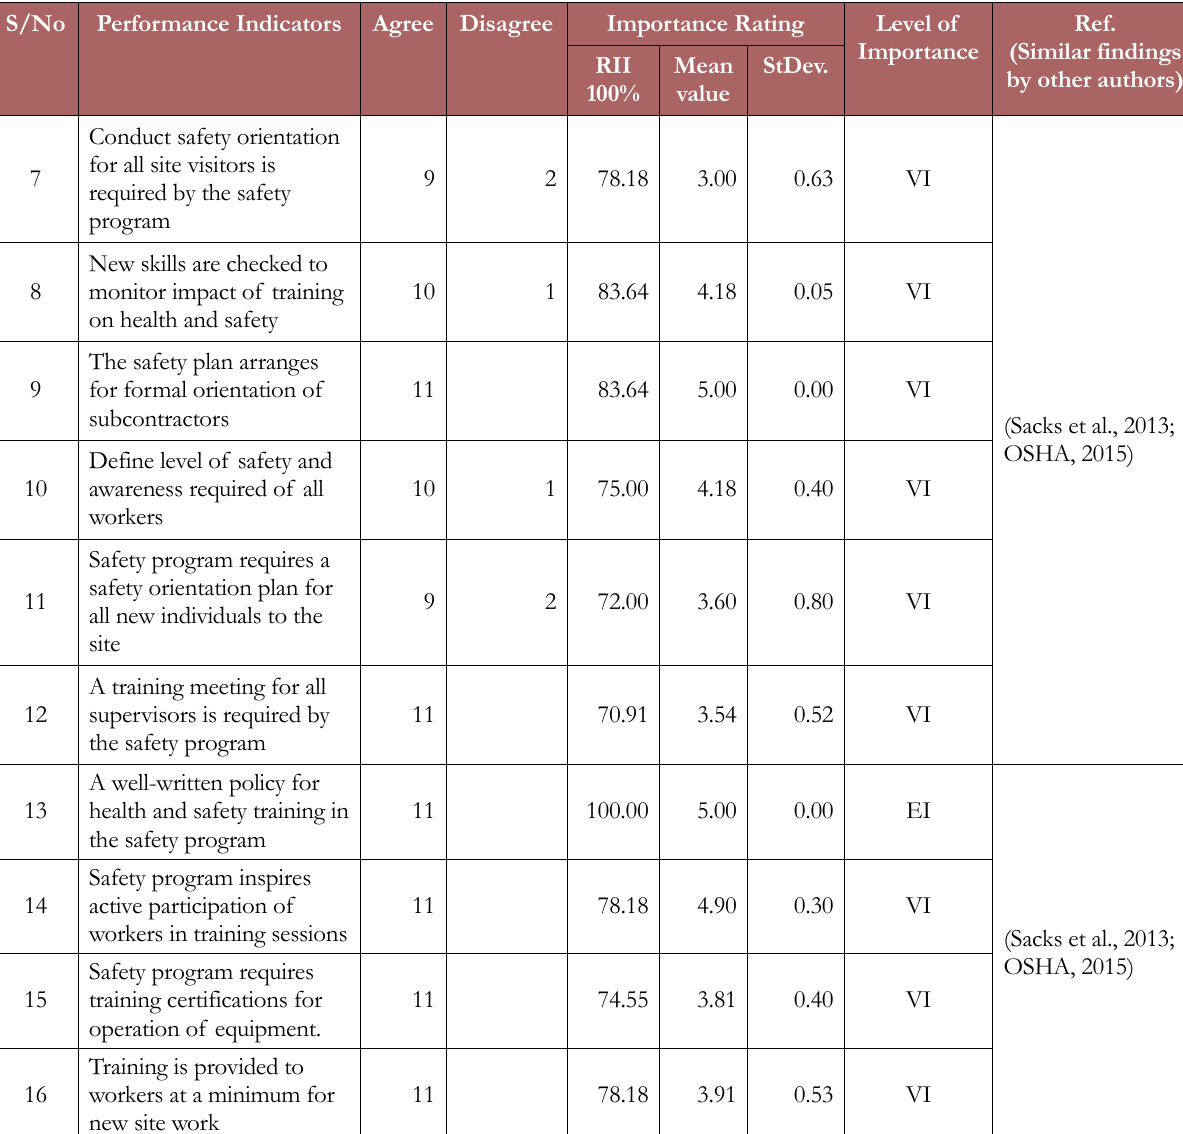
Table 7. Key Performance Indicators for Safety Training and